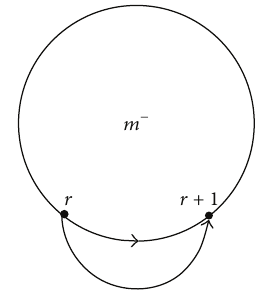
Figure 2: The inessential subregion.